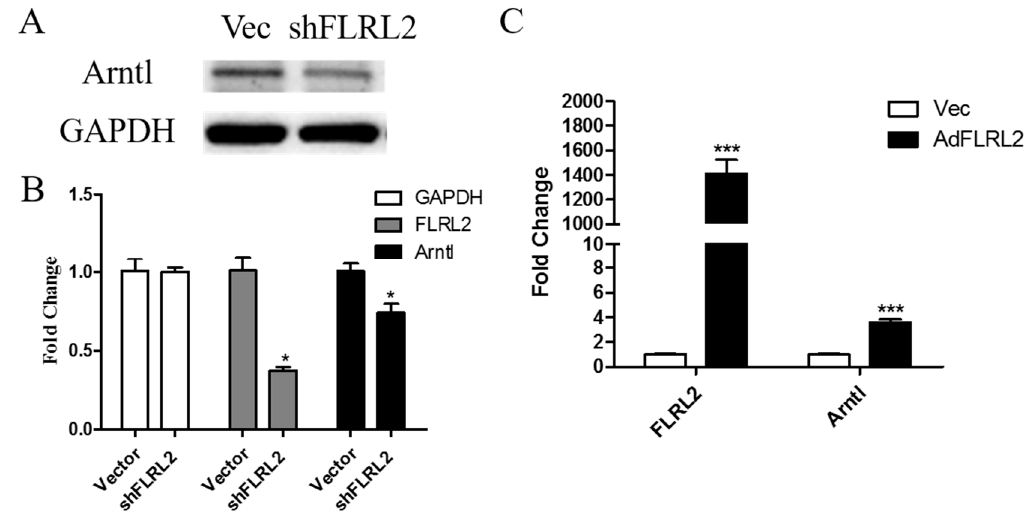
Figure 6. FLRL2 knockdown downregulates predicted target Arntl expression and vice versa. shFLRL2 plasmids and empty vectors as a control were transfected in AML12 cells for 48 h. Cell extracts were prepared for Western blot ( A ) and qPCR ( B ); FLRL2 overexpression vector, AdFLRL2 plasmid was transfected and total RNA were extracted after 48 h ( C ). mRNA levels of FLRL2 and Arntl were measured by qPCR and presented as the mean ± SD relative to the levels of control cells from three experiments. * p < 0.05; *** p < 0.001.